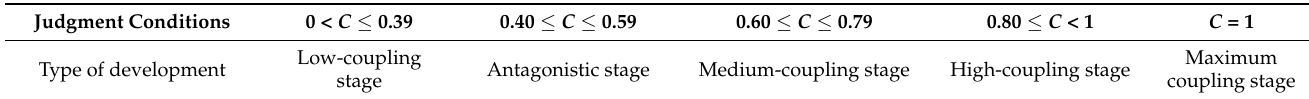
Table 4. Coupling type judgment criteria.